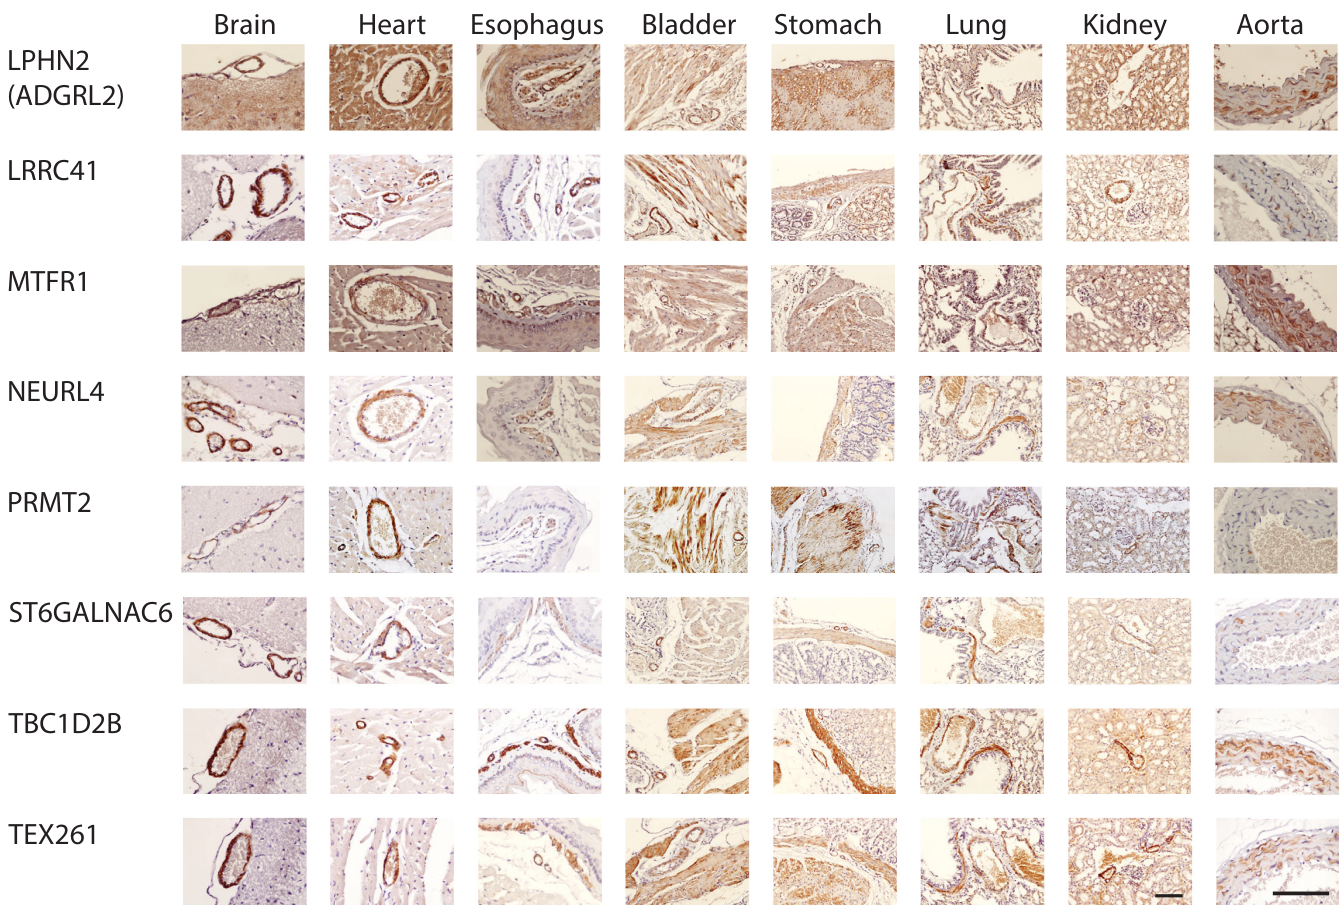
Fig 2. Smooth muscle protein expression in mouse tissues. Additional staining was performed using antibodies generated against proteins listed, as in Fig 1.